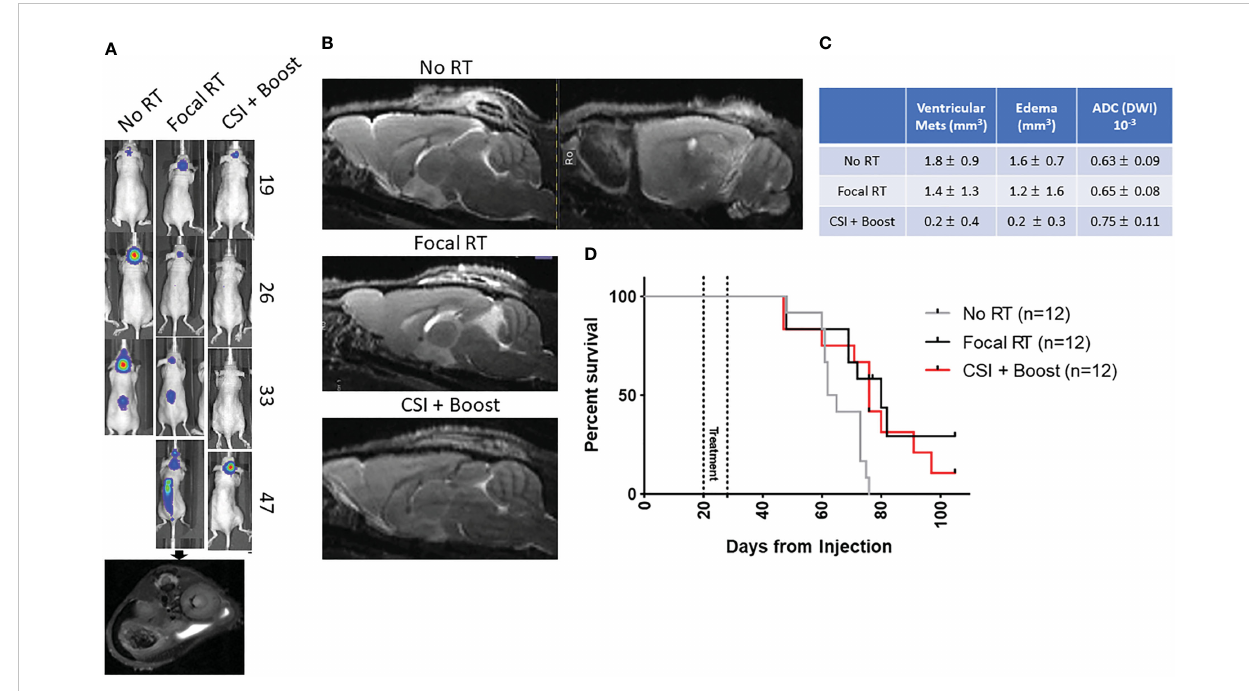
FIGURE 2 (A) Representative BLI for each group with day from tumor injection on the right, with a representative MRI con fi rming spinal tumor spread; (B) Representative sagittal T2 MRI images for the no RT (with T1 as well), focal RT, and CSI+boost groups show abnormal leptomeningeal and ventricular signal in the no RT/focal RT mice brains with no apparent metastases in the CSI+boost mouse brain; (C) Quantitative MRI endpoints for ventricular metastatic lesion volumes (T2-MRI), edema volumes (FLAIR, DWI), and apparent diffusion coef fi cients (DWI) showing mean values +/- standard deviation; (D) Kaplan-Meier curve for the three RT groups show prolonged survival for focal RT and CSI+boost groups compared to no RT (p=0.01 for both) but no difference in survival between the groups receiving RT (p=0.48).